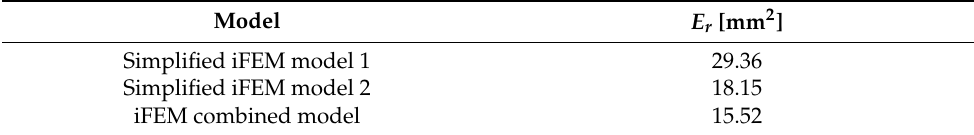
Table 4. Error functional of different simplified iFEM